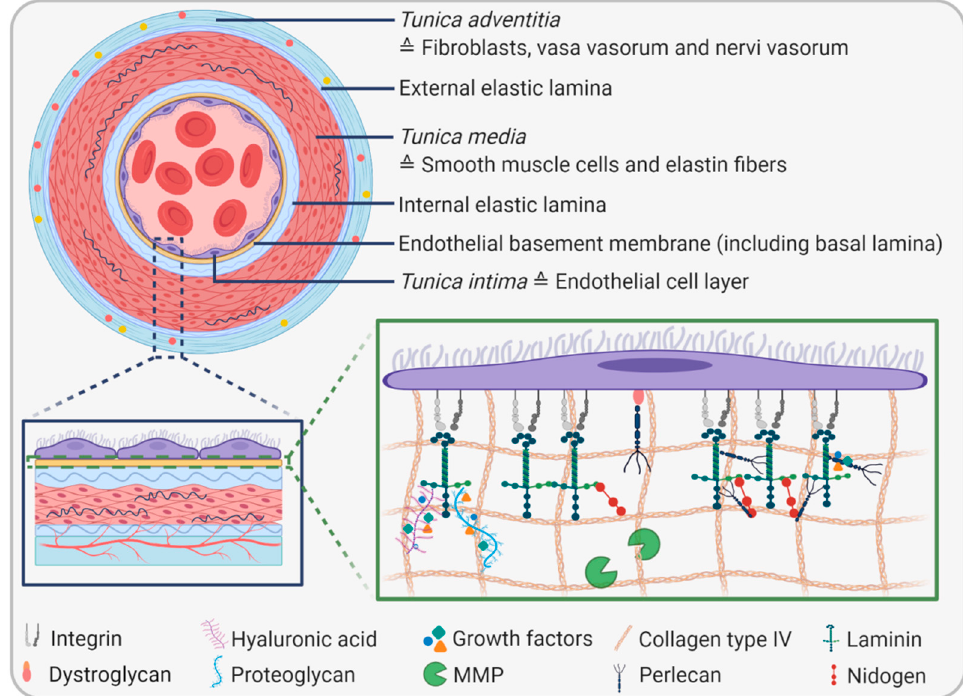
Figure 2. Structure of the endothelial basement membrane (EBM). The EBM (yellow layer) is located underneath the endothelial cell monolayer. The four major components are collagen type IV, laminin, perlecan, and nidogen. These molecules are connected to endothelial cells via adaptor proteins such as integrins and dystroglycans. Moreover, the EBM consists of proteoglycans and glycosaminoglycans, which act as binding partners for numerous growth factors. Proteases such as matrix metalloproteinases (MMPs) are also embedded in the EBM.